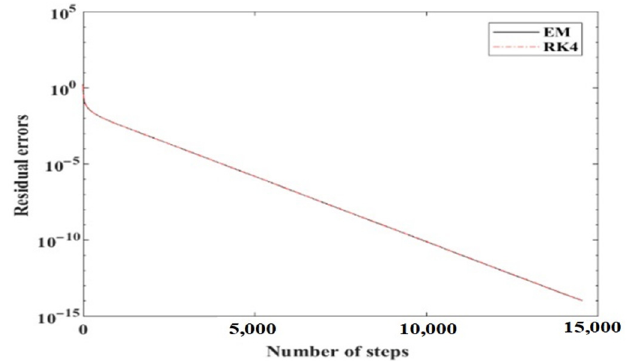
Figure 2. The convergence plot: red and black lines denote the RK4 and EM, respectively.